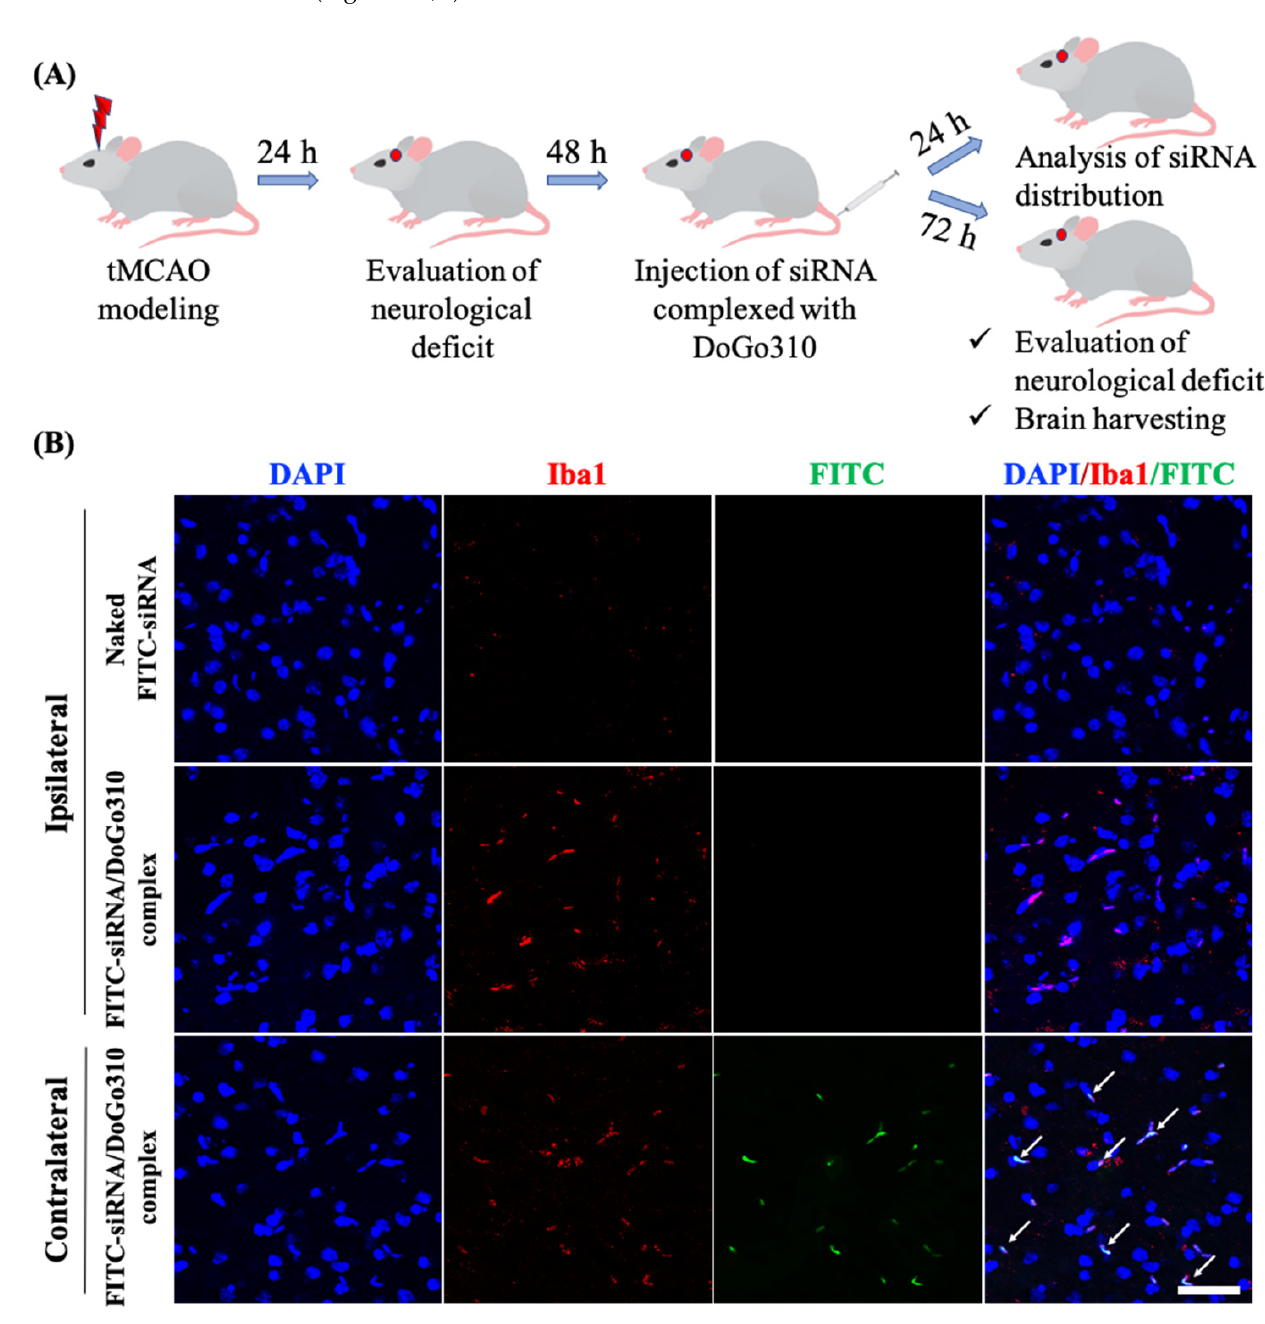
Figure 6. In vivo siRNA delivery by DoGo310 LNPs in tMCAO mouse. ( A ) Schematic illustration for siRNA administration and analytical process. ( B ) Immunohistochemistry staining showing the distribution of siRNA in peri-infarct region of contralateral as well as ipsilateral brain of tMCAO model mouse after i.v. injection of an FITC-label siRNA complexed to DoGo310 LNPs (dose of siRNA: 1.0 mg/kg body weight). Naked FITC-siRNA was injected as a negative control. Green, FITC-siRNA; red, Iba1. Scale bar = 50 μ m.